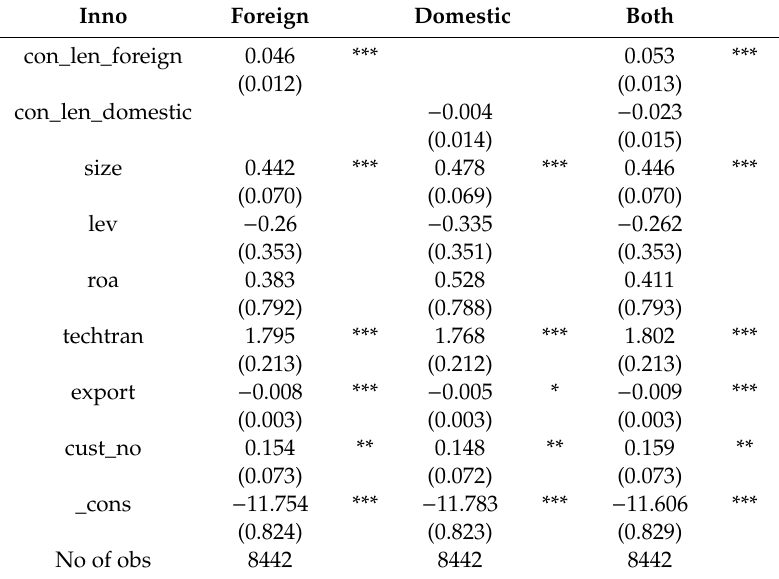
Table 3. Contract length and firm